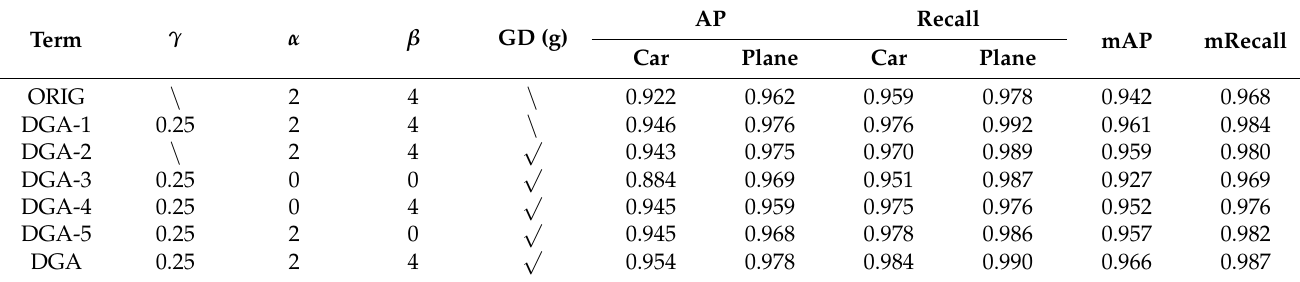
Table 1. Performance comparison among different setting of classification modules used on the UCAS-AOD dataset. mAP, mean Average Precision; mRecall, mean Recall; GD, gradient density; ORIG, baseline model CenterNet. AP Recall Term GD (g) mAP mRecall Car Plane Car